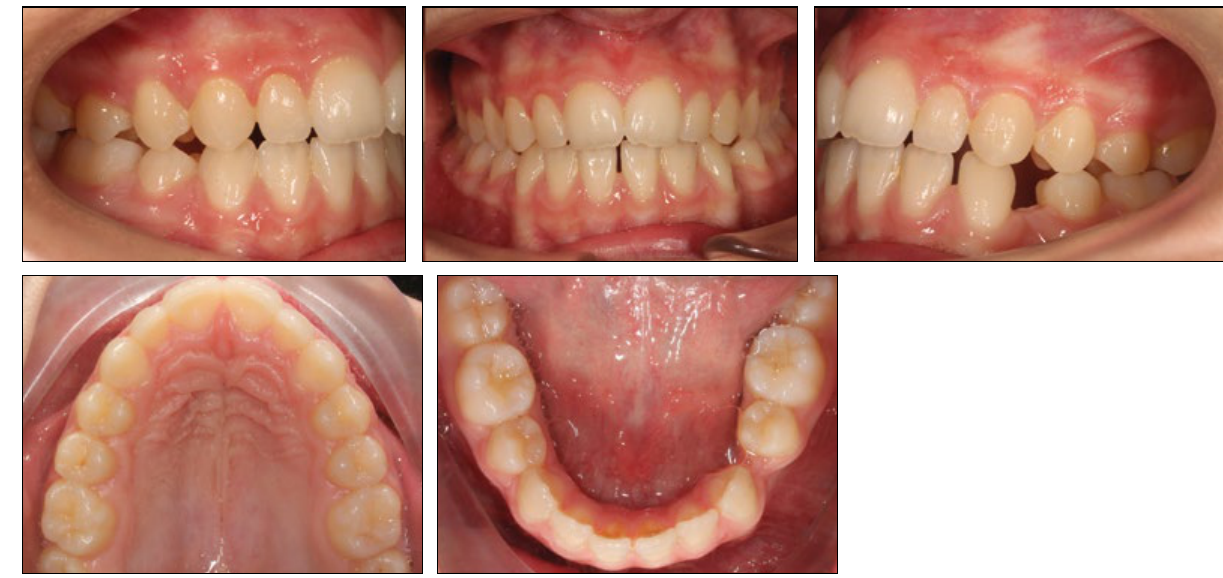
Figure 5. Intraoral photographs taken at one-year